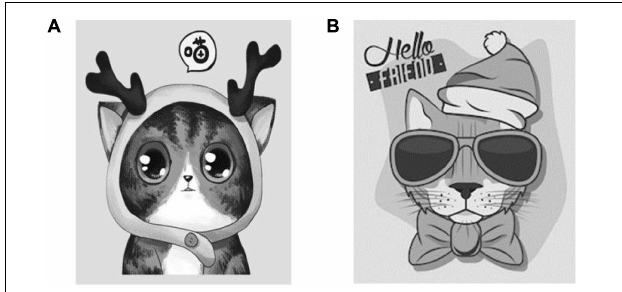
FIGURE 2 | Brand anthropomorphic images of cuteness (A) and coolness (B) in Study